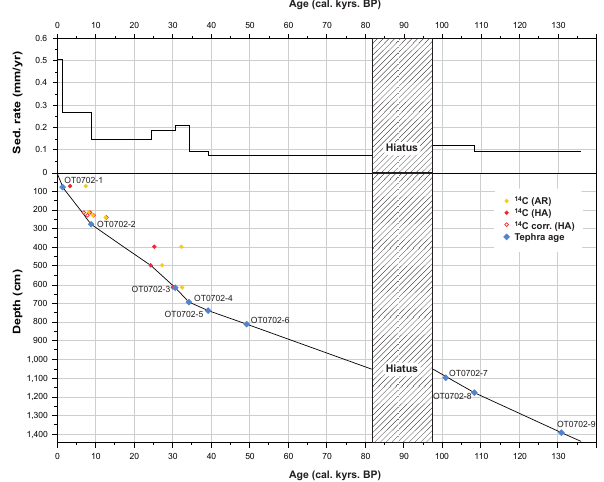
Fig. 2. Age-depth model for Co1202, showing estimated sediment accumulation rates. Radiocarbon ages were derived from alkaline residue (AR) and humic acid (HA) fractions of bulk sediment. Open circles denote corrected HA ages. Tephra age includes tephra and cryptotephra. See Vogel et al. (2010a) for more detail. (Modified from Vogel et al.,